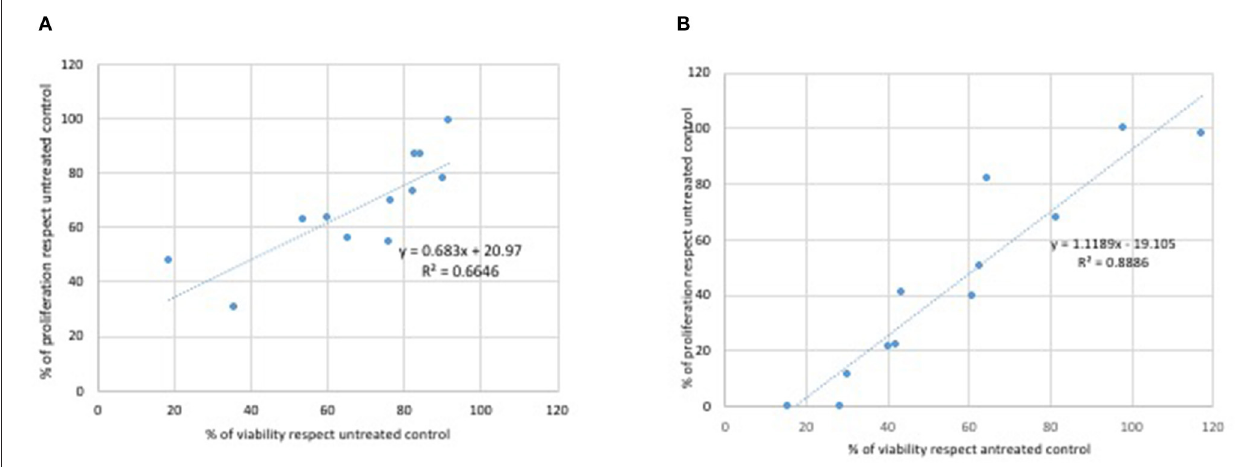
FIGURE 5 | Correlation between MTT and Trypan Blue test for L929 cells treated with different doses of Glyphosate (A) and Roundup (B) . Both correlations were statistically significant at P < 0.05.